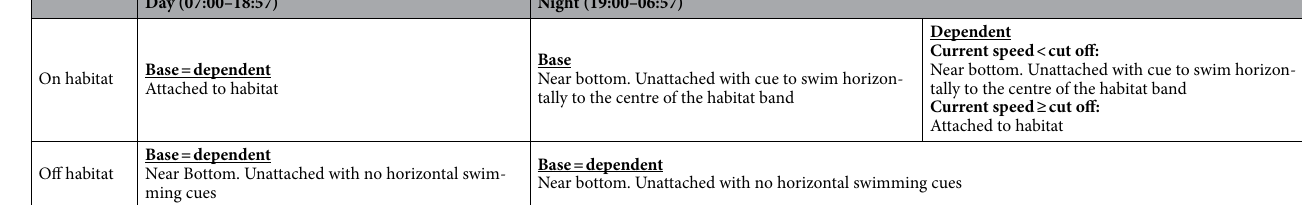
Dependent Current speed < cut off: Near bottom. Unattached with cue to swim horizon- tally to the centre of the habitat band Current speed ≥ cut off: Attached to habitat